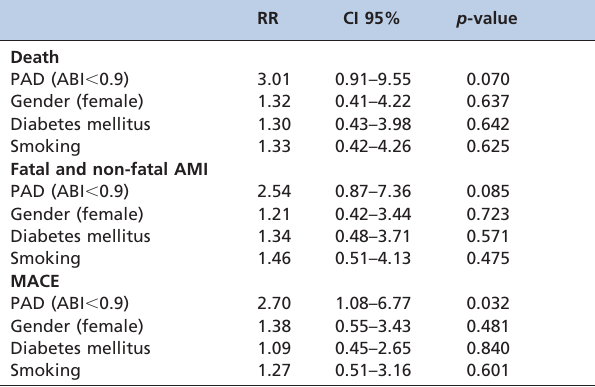
Table 2 - Analysis of the incidence of death, fatal and non-fatal acute myocardial infarction and major cardiovascular events related to cardiovascular risk factors and the presence of peripheral arterial disease (PAD) evaluated by the ankle-brachial